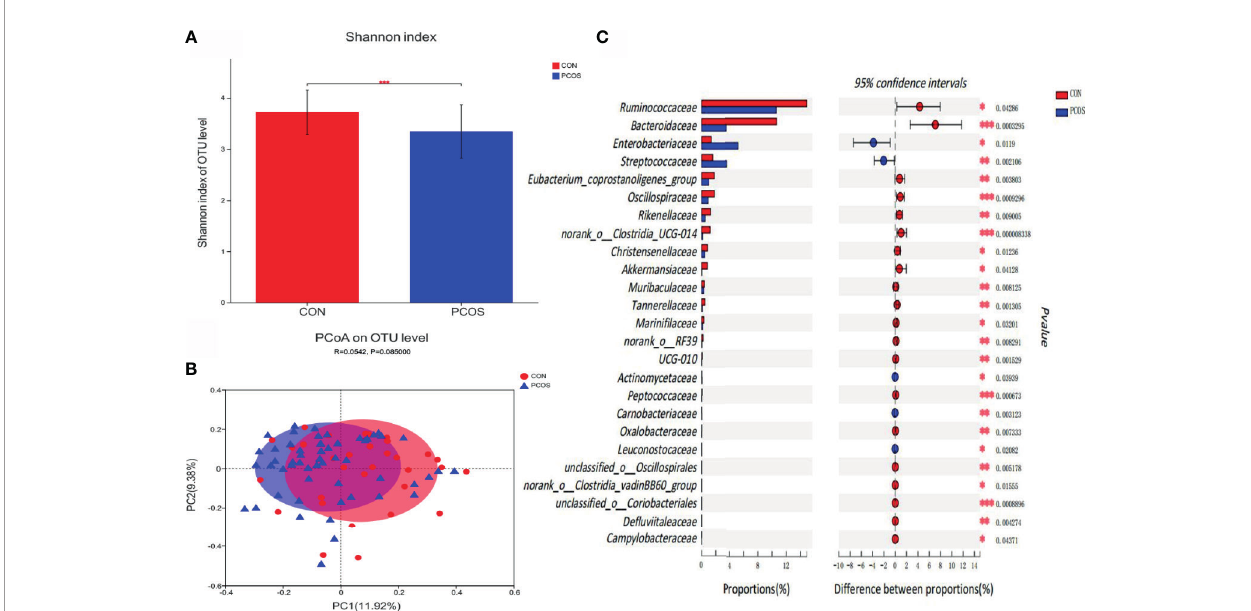
FIGURE 1 | Comparative analysis of gut microbiota between CON and PCOS groups. (A) The Shannon index of OTU level showed the difference between CON and PCOS groups. (B) Principal coordinate analysis (PCoA) of gut microbiota was based on Bray Curtis faith distance (ANOSIM, P = 0.085, R = 0.0.0542 ). Each point represents the bacterial community composition of a single fecal sample, and the axis title represents the percentage change of interpretation (11.92% for PC1 and 9.38% for PC2). (C) 25 groups of gut microbiota with statistical difference between CON and PCOS were screened out. *P < 0.05, **P < 0.01, ***P <